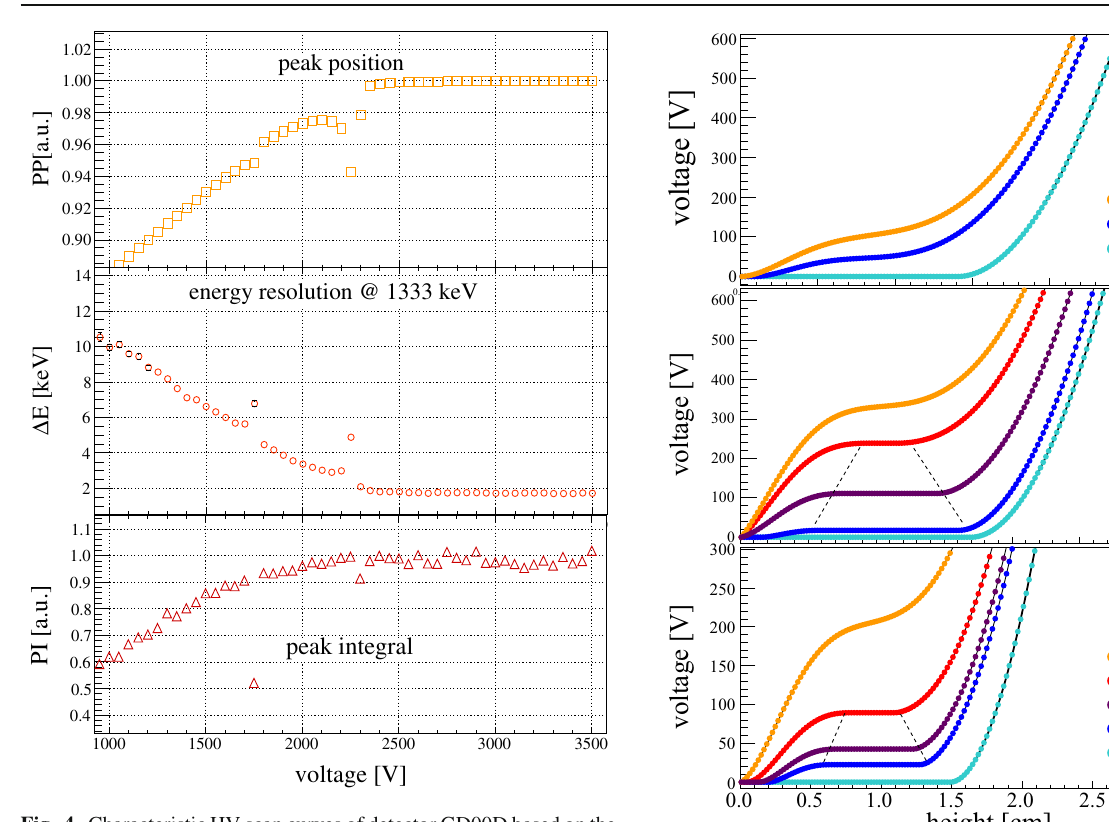
Fig. 4 Characteristic HV scan curves of detector GD00D based on the evaluation of the 1333 keV γ line from a 60 Co calibration source. For a givencurve,thedistancebetweentwovaluesare50V.Inallthreecurves of the peak position, energy resolution and peak integral the presence of two ‘bubbles’ becomes visible